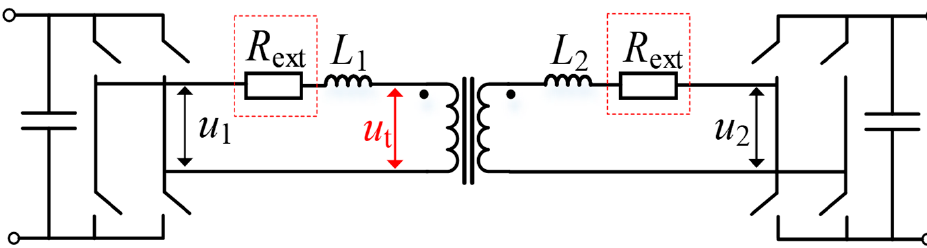
Figure 4. DAB circuit with external AC resistors.